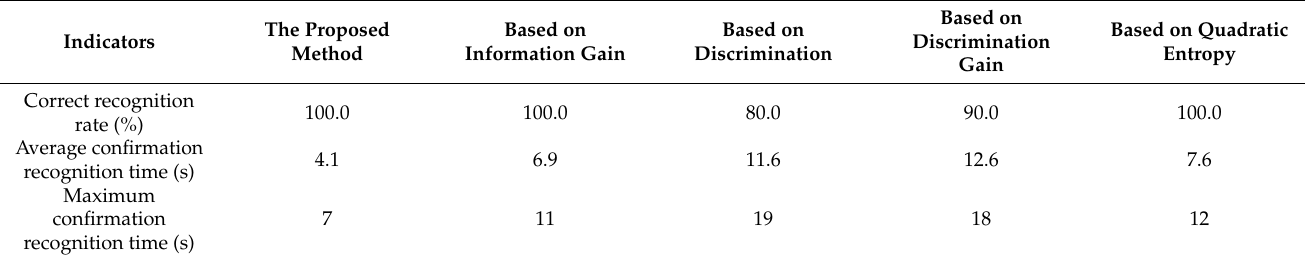
Table 2. Performance comparison of sensor management